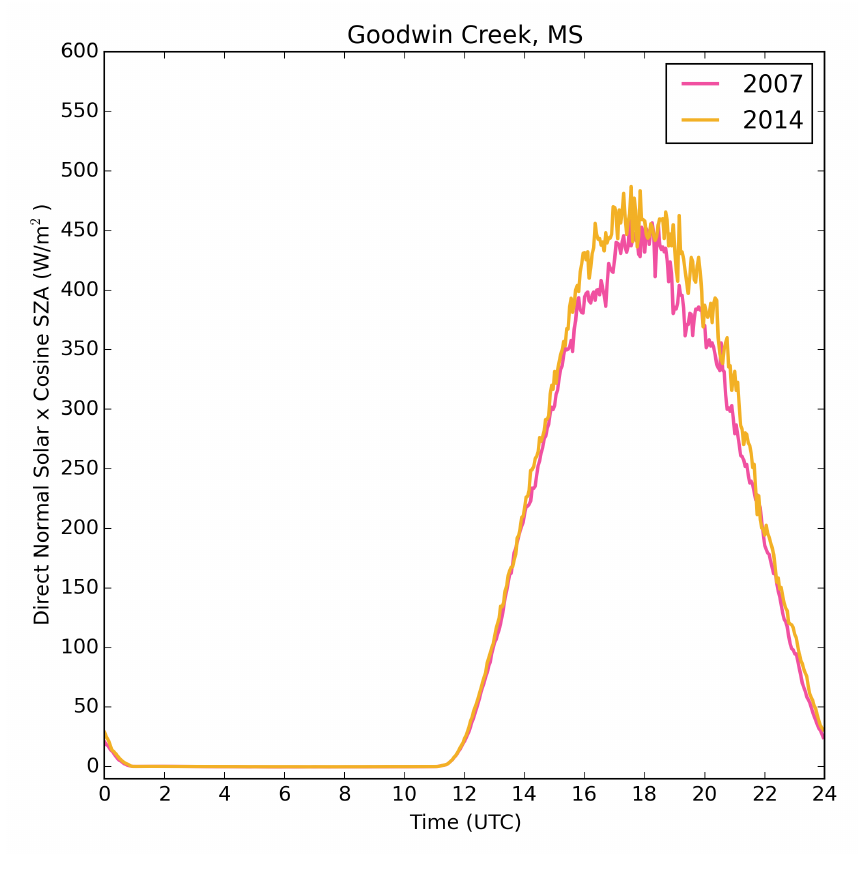
. Figure 6. A diurnal time series of average summertime (May–September) direct minus normal surface radiation received at Goodwin Creek, MS, USA for 2007 (pink) and 2014